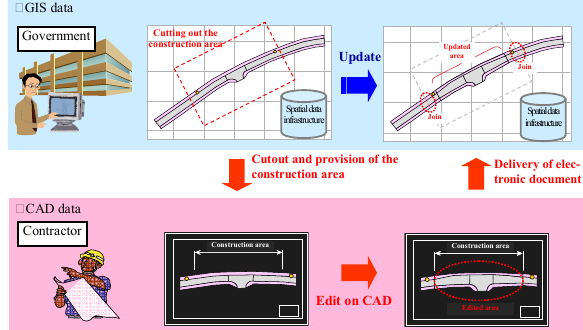
Figure 5. Partial updating cycle of road